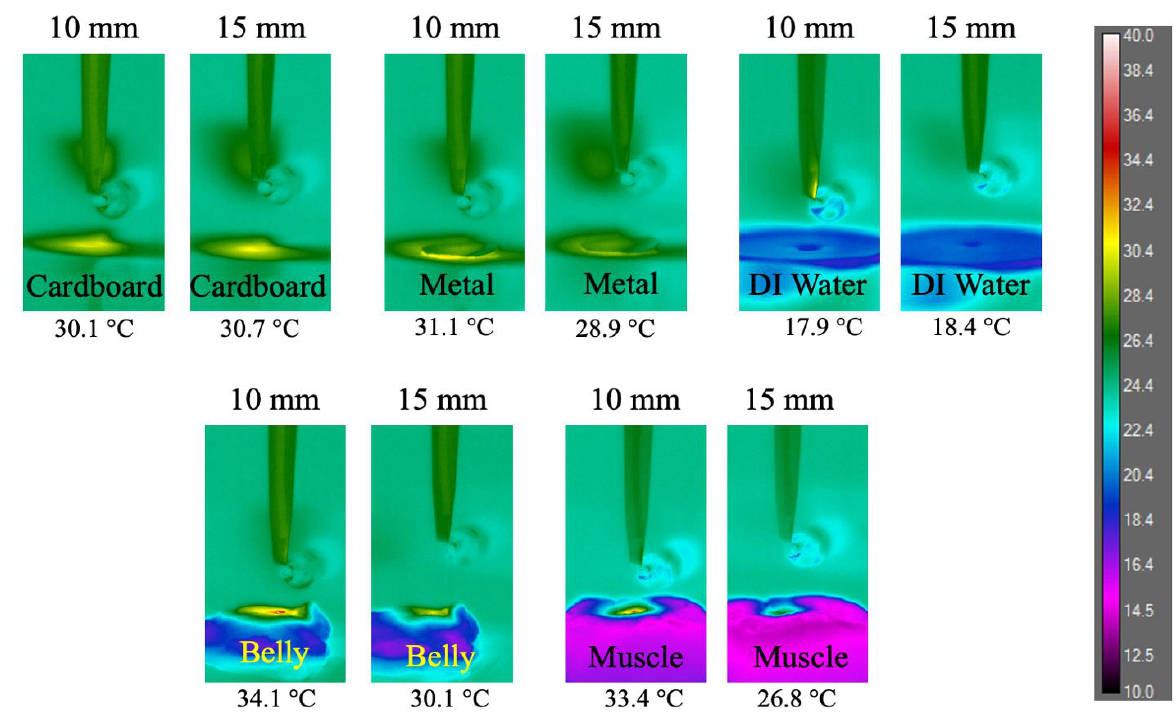
Figure 6. Thermal measurement of the tiny plasma jet interacting with cardboard, metal, DI water, belly, and muscle for 2 min at 10 mm and 15 mm distances. The temperature marked below each image is the center temperature of a tiny plasma jet interacting with subjects.